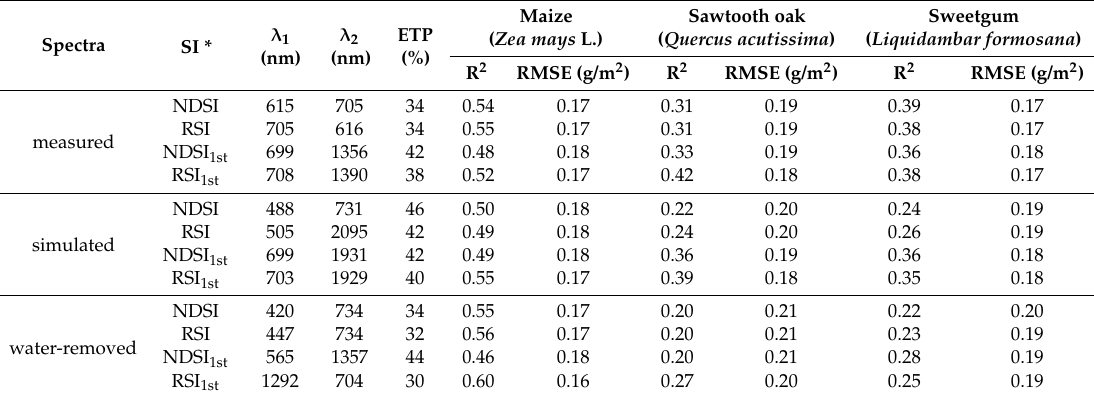
Table 3. Statistics of the cross-species optimal spectral